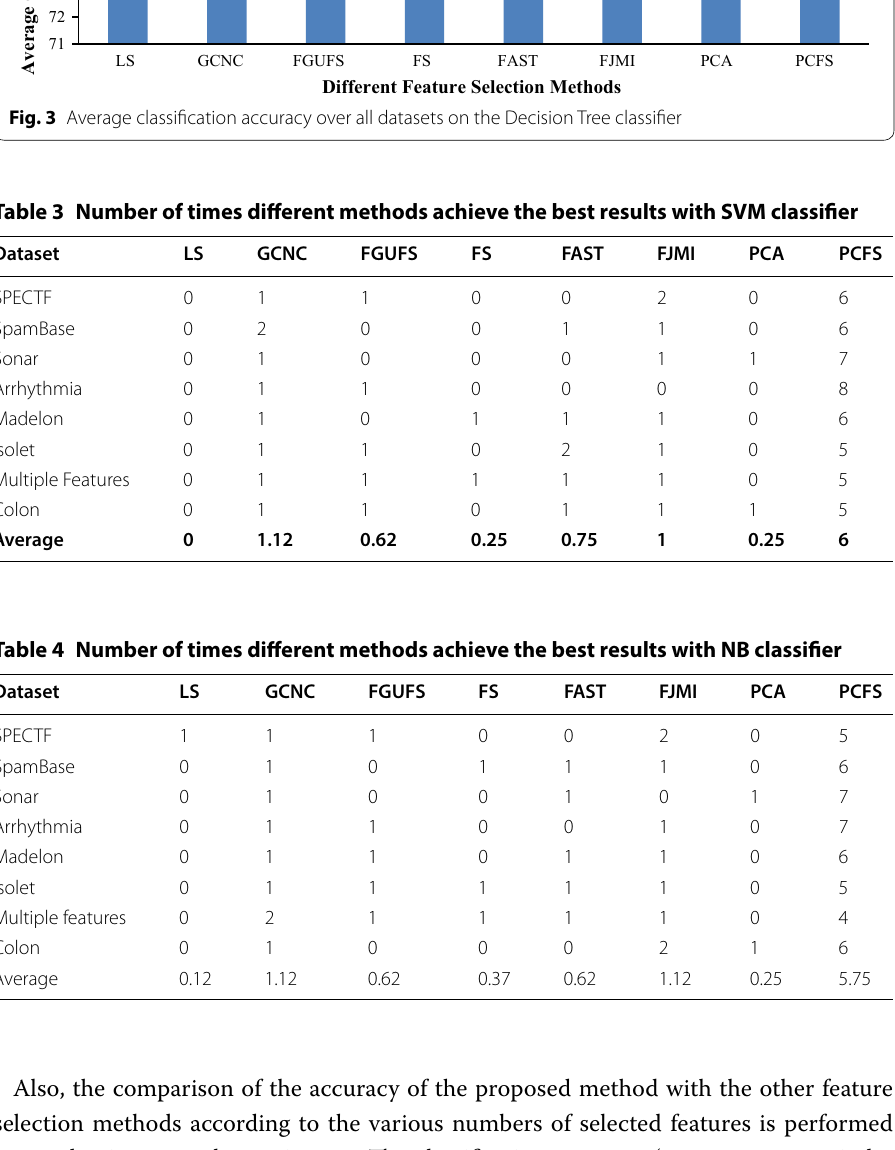
Fig. 3 Average classification accuracy over all datasets on the Decision Tree classifier